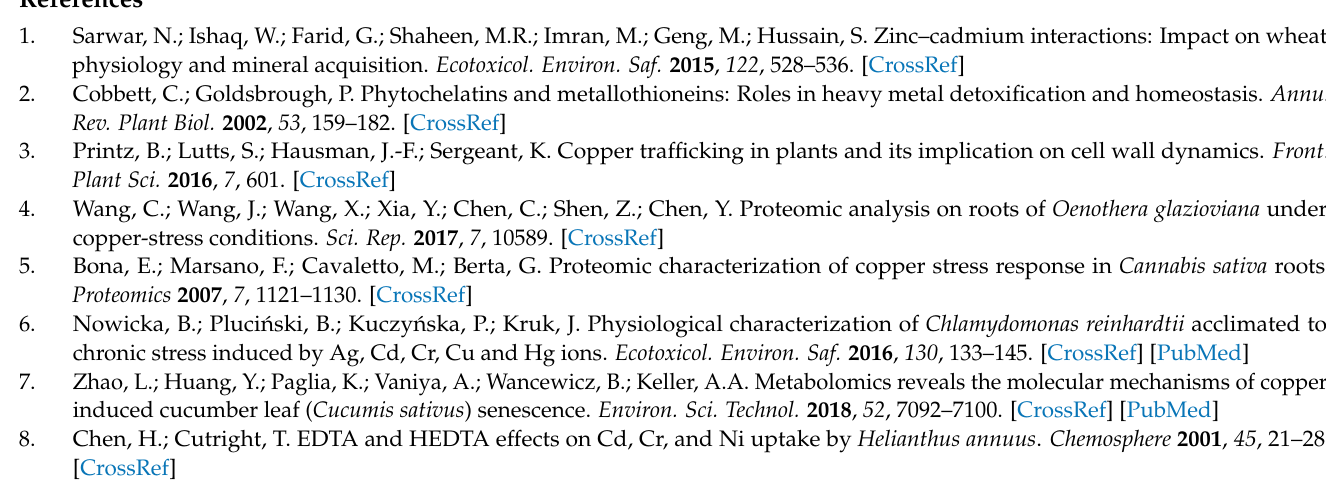
Supplementary Materials: The following are available online at https://www.mdpi.com/article/ 10.3390/ijms22115879/s1, Figure S1. Schematic representation of the experimental setup used to investigate the CA assisted Cu-tolerance in B. napus seedlings; Figure S2. Venn diagram of total identified proteins showing common and unique proteins in each comparison groups; Figure S3: significantly enriched GO terms for the DAPs between the treatment groups (CK vs. CA) in B. napus seedling leaves under CA-mediated Cu stress; Figure S4: significantly enriched GO terms for the DAPs between the treatment groups (CK vs. Cu25 µ M) in B. napus seedling leaves under CA-mediated Cu stress; Figure S5: significantly enriched GO terms for the DAPs between the treatment groups (CK vs. CA + Cu25 µ M) in B. napus seedling leaves under CA-mediated Cu stress; Figure S6: significantly enriched GO terms for the DAPs between the treatment groups (CK vs. Cu50 µ M) in B. napus seedling leaves under CA-mediated Cu stress; Figure S7: significantly enriched GO terms for the DAPs between the treatment groups (CK vs. CA + Cu50 µ M) in B. napus seedling leaves under CA-mediated Cu stress; Table S1: primers used for qRT-PCR analysis; Table S2: list of differentially abundant proteins (DAPs) identified in this study. Cells with blue and yellow color indicate significant fold changes of increase or decrease in response to CA-mediated Cu stress; Table S3: list of differentially abundant proteins among the treatment groups; Table S4: GO annotation of the total identified proteins in B. napus seedlings in response to CA-mediated Cu stress using DAVID Bioinformatics; Table S5: KEGG pathways of the total identified proteins in B. napus seedlings in response to CA-mediated Cu stress using DAVID Bioinformatics, Table S6: significantly enriched GO terms for the DAPs among the treatment groups in B. napus under CA-mediated Cu stress; Table S7: list of significantly enriched KEGG pathways for the DAPs among the treatment groups in B. napus seedlings in response to CA-mediated Cu stress using DAVID Bioinformatics. Author Contributions: Conceptualization and data curation, S.-H.W., K.C. and S.K.R.;